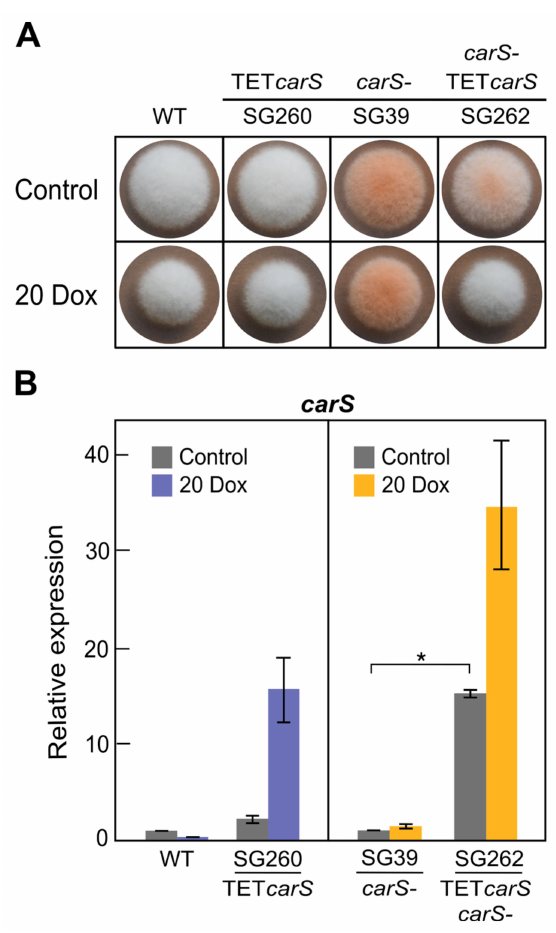
Figure 3. Control of expression of the carS gene using the Tet-on system in F. fujikuroi : ( A ) Phenotypic characterization of TET carS transformant (SG260 and SG262) and parental strains, wild type (WT) and SG39 ( carS mutant), grown in DG agar medium (control) and in DG with 20 µ g/mL Dox (20 Dox) at 30 ◦ C for five days in the dark. ( B ) Transcripts levels of the carS gene in the strains grown in minimal DG medium for 18 h and induced with 20 µ g/mL of Dox (20 Dox) or grown without Dox (control) and then incubated for up to three days in darkness. Values in the left graph refer to those of WT without Dox, and values in the right graph refer to those of SG39 without Dox. The qRT-PCR data are the average of two independent experiments and bars represent the standard deviation. *-indicates p <